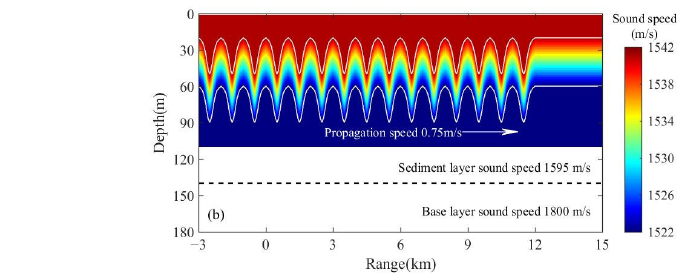
Figure 5. Background sound-speed fields for acoustic simulation at different times: ( a ) t = 0 and ( b ) t = 4.44 h. The sound-speed fields are constructed based on Equations (7) and (8).